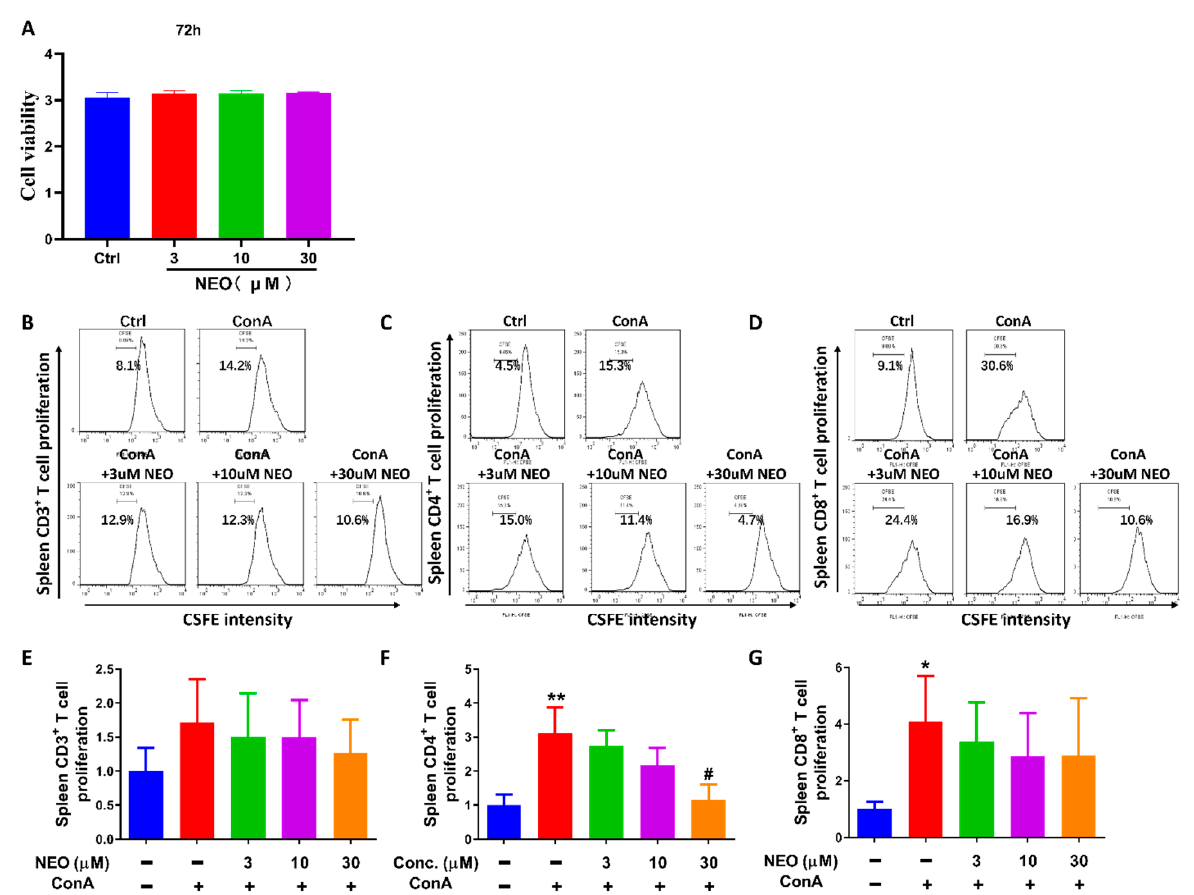
Figure 3. Effect of NEO on splenocytes viability and T cell proliferation. ( A ) Impact of NEO on splenocytes viability. ( B , E ) Effect of NEO on CD3 + T cell proliferation. ( C , F ) Inhibition of NEO on CD4 + T cell proliferation. ( D , G ) Effect of NEO on CD8 + T cell proliferation. The results represent three independent experiments. * p < 0.05, and ** p < 0.01 indicated that the differences were statistically significant vs. control group; whereas, # p < 0.05 declared statistically significant differences vs. ConA-stimulated group (n = 3).